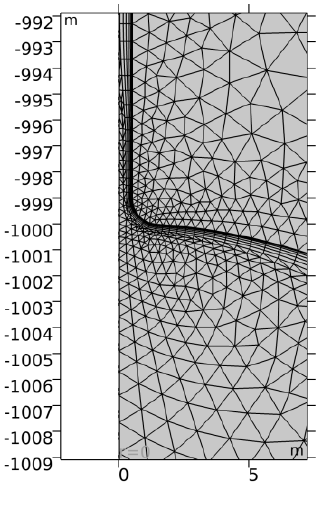
Figure 3. Model mesh